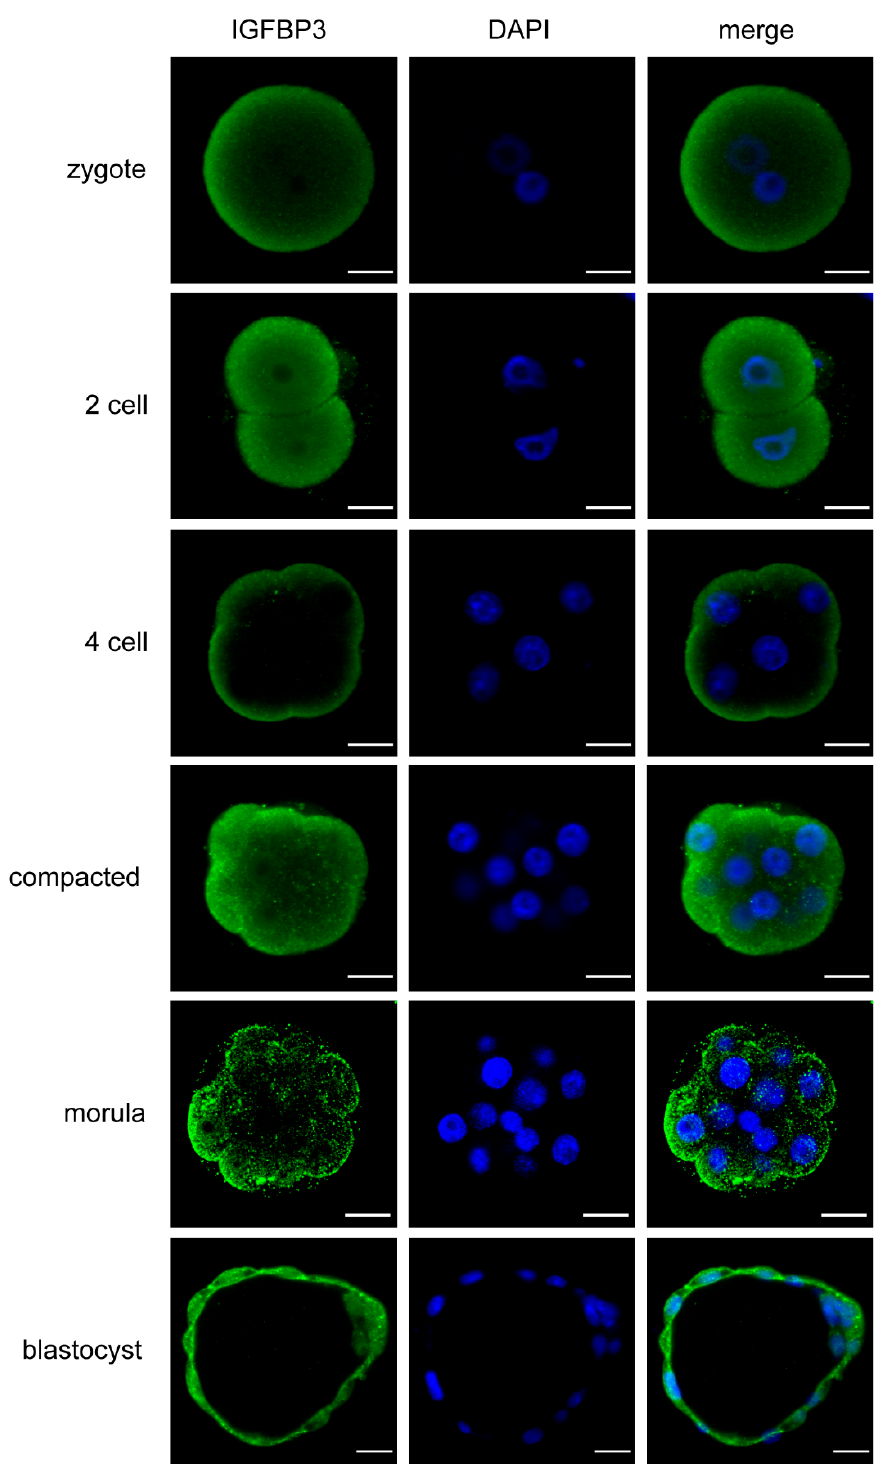
Figure 1. IGFBP3 expression in preimplantation embryos. Representative confocal images of preim- plantation stage embryos isolated from the reproductive tract and immunostained for IGFBP3 (green) and co-stained with DAPI (blue). Scale bar represents 20 μ m. Images are representative of at least 10 embryos per stage.